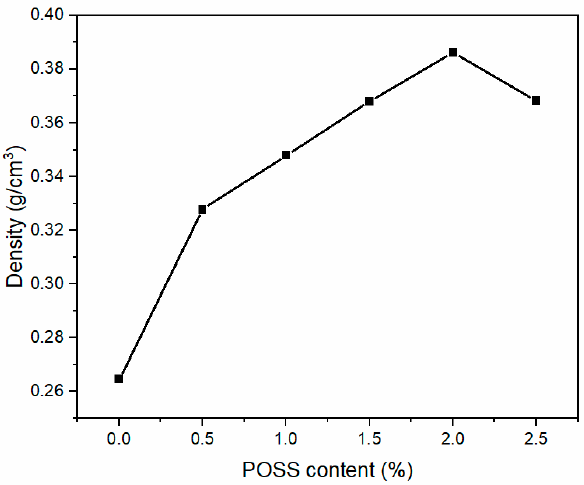
Figure 6. The cell density of polysiloxane foam with di ff erent MAPOSS content.